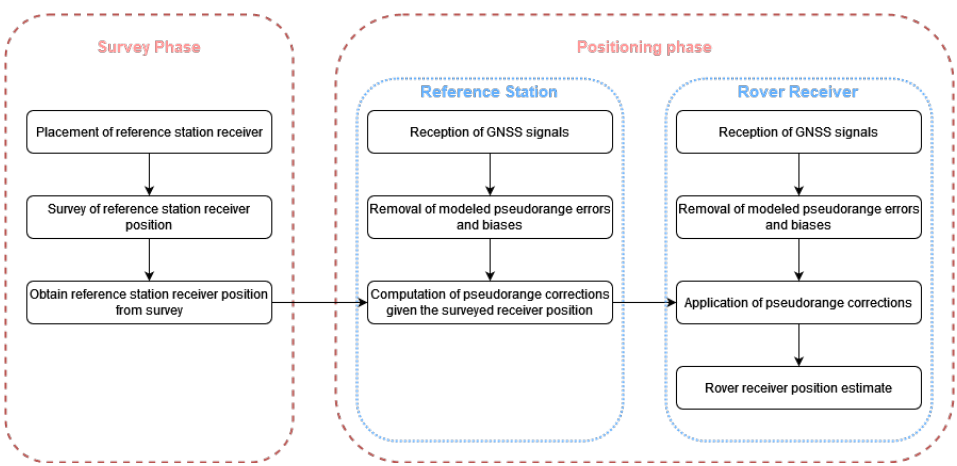
Figure 1. Overview of the DGNSS positioning